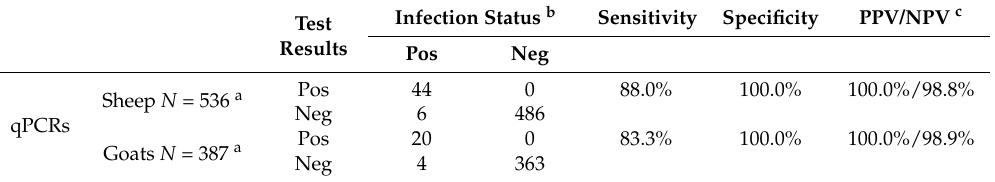
Table 5. 2 × 2 contingency tables summarizing qPCR results in leucocyte pellets compared to the defined infection status based on six serological